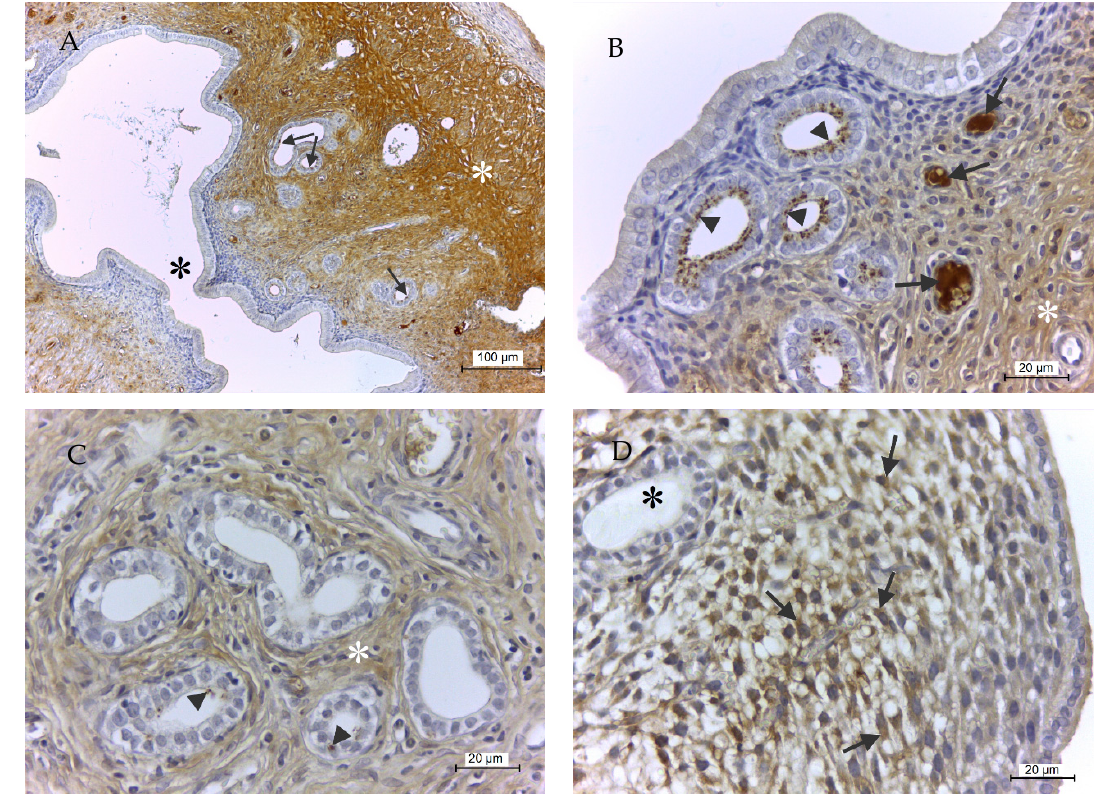
Figure 4. GPx8 presence in rat uterus. ( A ) is an overall view of protein presence on D1. The black asterisk represents the uterine cavity, the white asterisk means protein in endometrium and myometrium, and arrows indicate protein in uterine glands. ( B ) shows in detail that the enzyme was particularly detected in apical parts of cells of uterine glands (arrowheads), plasma in blood vessels (arrows), and extracellular matrix of the endometrium (white asterisk). On D3 ( C ), only very small residues of enzyme remained in the uterine glands (arrowheads), while enzyme in extracellular matrix of endometrium was still present (white asterisk). On D5 ( D ), the enzyme completely disappeared from uterine glands (black asterisk), but on the other hand, enzyme emerged in stellate-like fibroblasts of the endometrium (arrows). GPx8 was never observed in epithelial or muscular cells of the uterine wall, regardless of days of pregnancy.